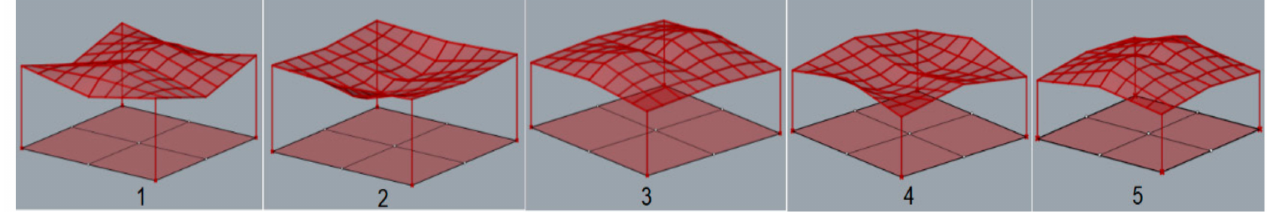
Figure 5. Various models of the roof structures composed of cylindroid units obtained due to simulations.